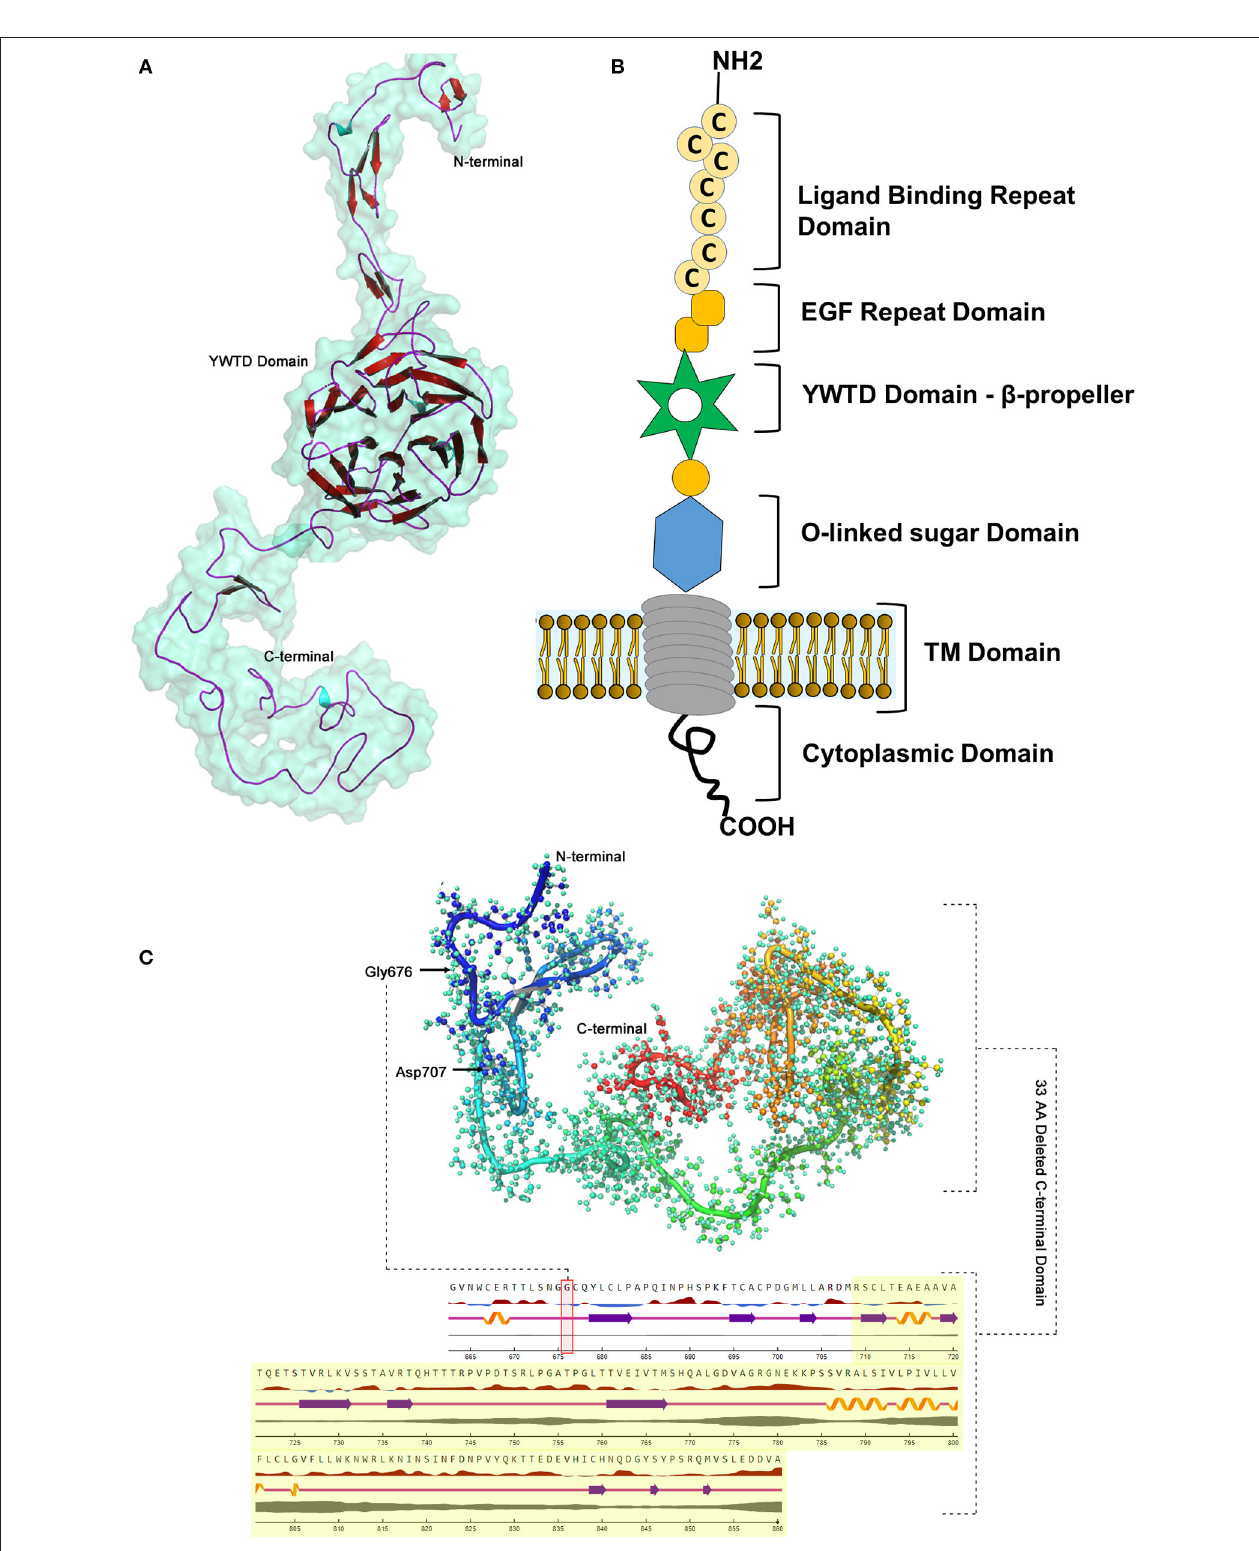
FIGURE 5 | LDLR protein structure visualization. (A) 3D structural representation of the protein molecule. (B) Functional domains distribution. (C) The p.G676Afs*33 variant effect on the secondary structure organization on the protein.